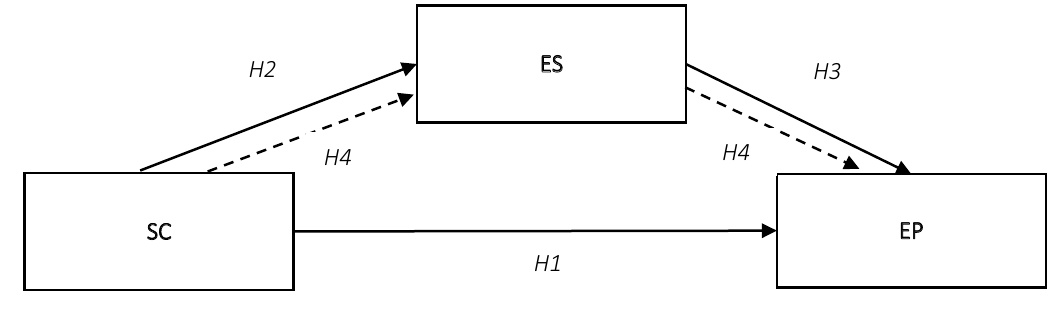
Figure 1. Research